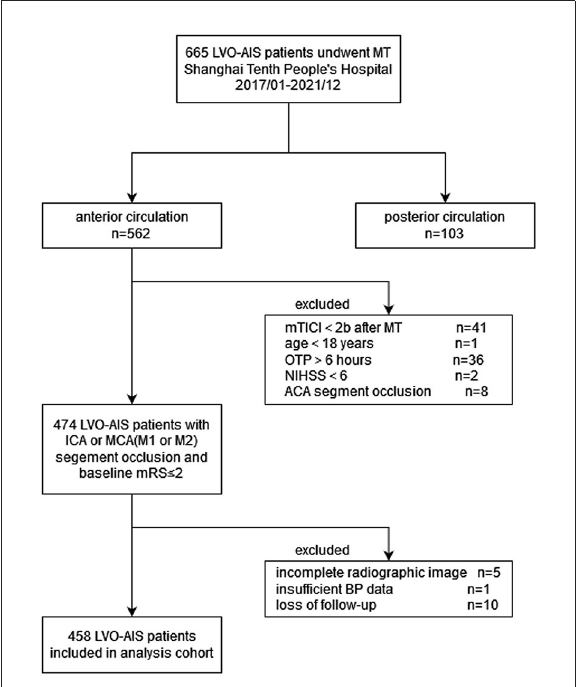
FIGURE1 Flow chart of patient inclusion. LVO, Large vessel occlusion; AIS, acute ischemic stroke; MT, mechanical thrombectomy; mTICI, modified tissue thrombolysis in cerebral ischemia; OTP, onset to Puncture time (minute); NIHSS, national institutes of health stroke scale; ACA, anterior cerebral artery; ICA, internal carotid artery; MCA, middle cerebral artery; mRS, modified Rankin Scale; BP, blood